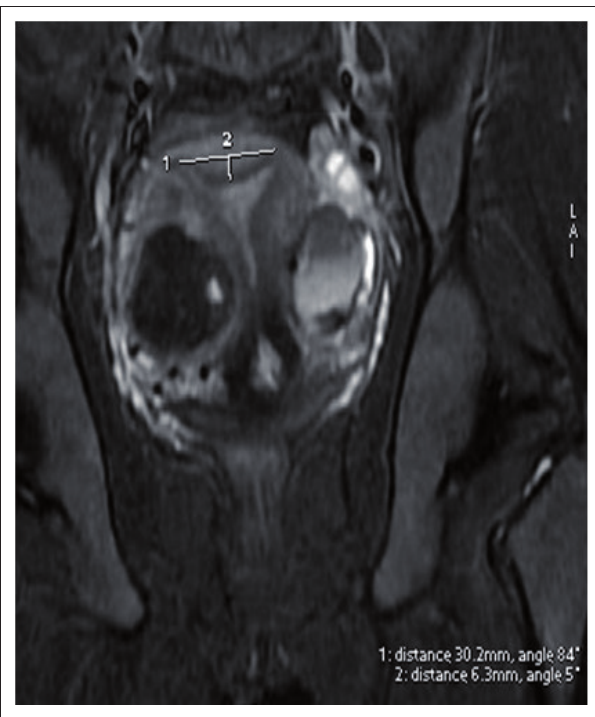
Society for Gynecological Endoscopy– Class U0 – Normal Uterus. American Society for Reproductive Medicine– Normal uterus. FIGURE 7: Coronal oblique T2 sequence shows a normal uterus. No fundal external dipping, intercornual distance of less than 4 cm and internal fundal muscular indentation of less than 50 % of the uterine wall thickness. Associated right lateral wall intramural fibroid and left benign teratoma